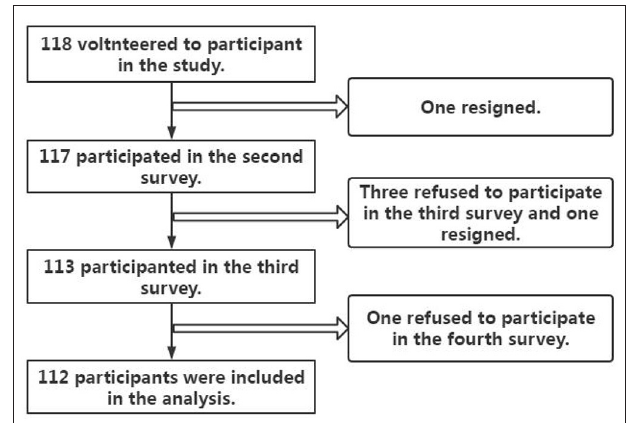
FIGURE 1 | Flowchart of the medical staff